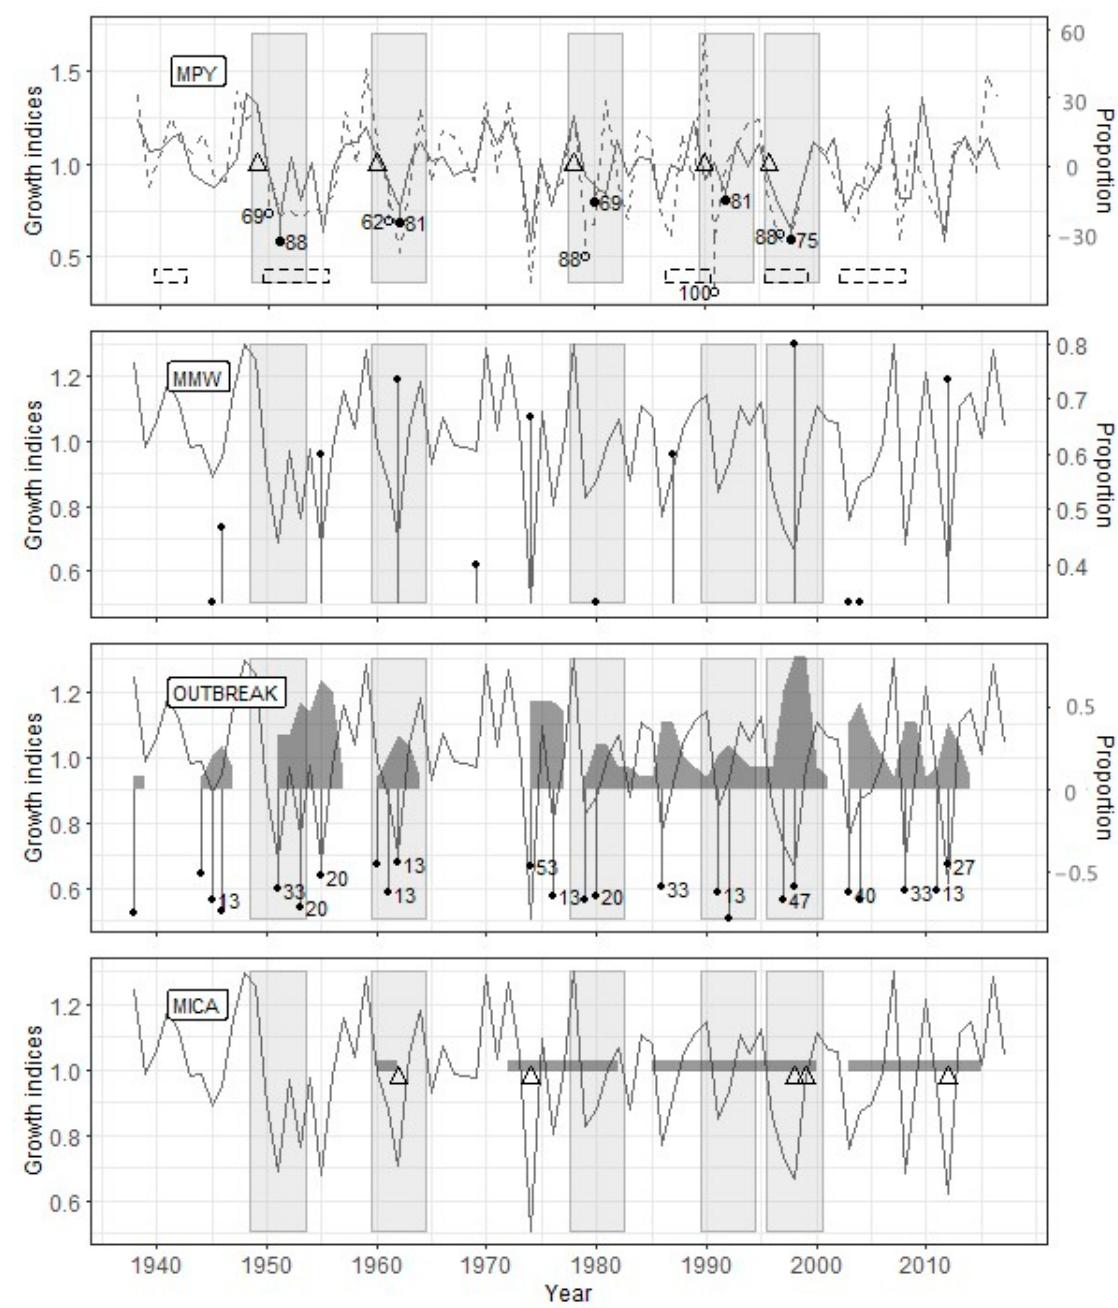
Figure 5. Reconstruction results for the Lesnoye site. Legend as for Figure 3.